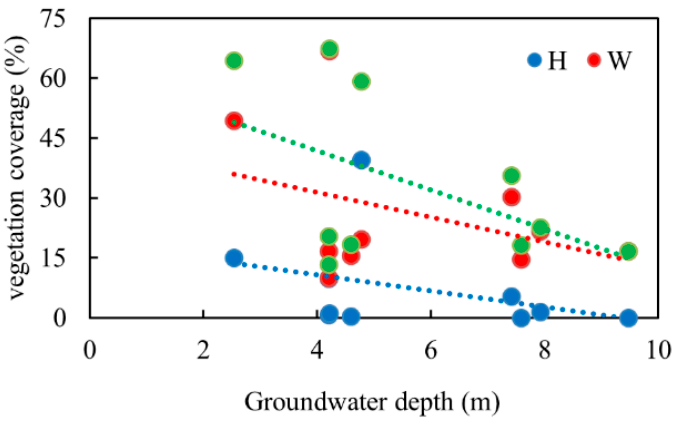
Figure 6. The variation of vegetation coverage of herbaceous plants, woody plants, and total plants with groundwater depth. “H” refers to herbaceous plants, “W” refers to woody plants, and “T” (Total) refers to both herbaceous and woody plants.